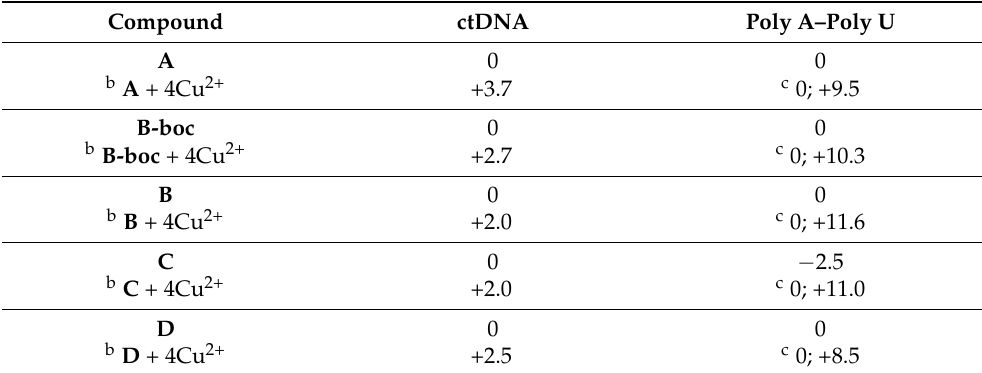
0 +3.7 0 +2.7 0 +2.0 0 +2.0 0 +2.5